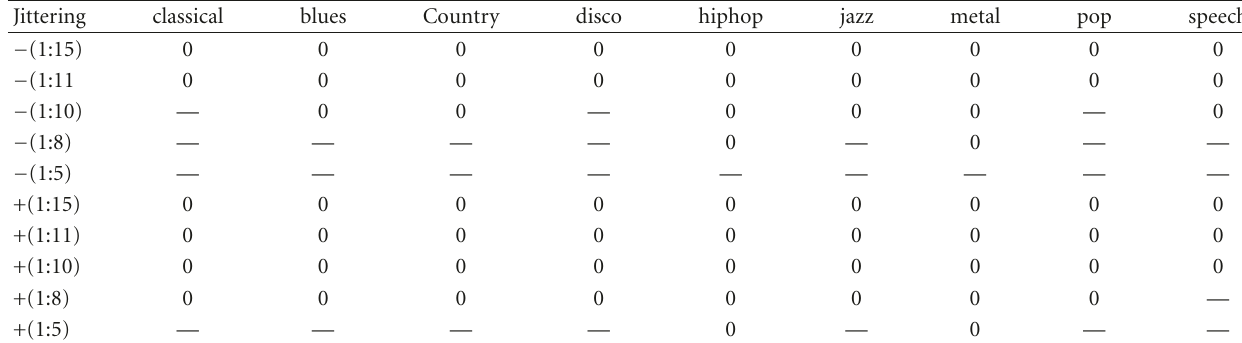
Table 4: Robustness to jittering (Watermark length =